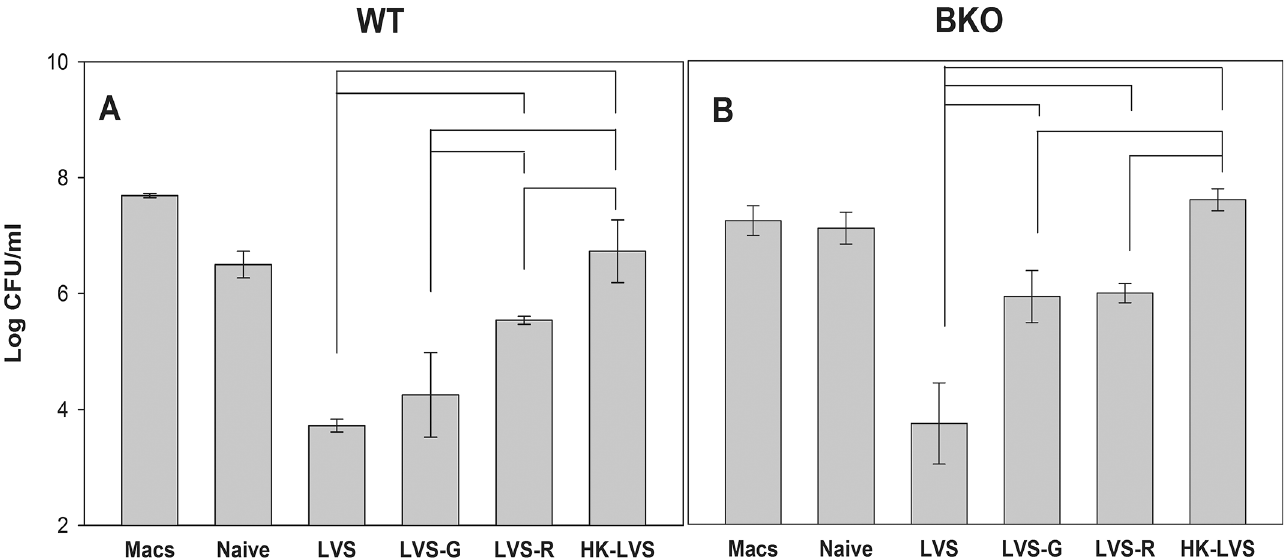
Fig 1. Splenocytes from LVS-related vaccinated mice exhibit a hierarchy of control of intramacrophage LVS growth. BMM Φ from BALB/cByJ mice were infected with LVS (Macs), and co-cultured with splenocytes obtained from na ï ve or vaccinated BALB/cByJ mice (Panel A), and from naive or vaccinated BKO mice (Panel B), as indicated. After two days of co-culture, BMM Φ were washed, lysed, and plated to evaluate the recovery of intracellular bacteria. Values shown are the mean numbers of CFU/ml ± SD of viable bacteria for triplicate samples. Results shown are from one representative experiment of seven (using splenocytes of BALB/cByJ mice) or four (using splenocytes of BKO mice) independent experiments of similar design and outcome. Brackets indicate a significant difference ( P < 0.05) between the recoveries of bacteria in co-cultures. There were no significant differences between the recovery of bacteria from co-cultures using LVS-immune cells and LVS-G-immune cells (Panel A) and the recovery of bacteria from co-cultures using LVS-G-immune cells and LVS-R-immune cells (Panel B).